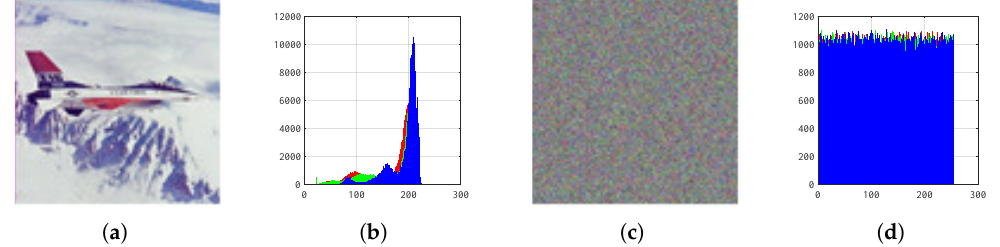
Figure 7. Histograms: ( a ) Airplane image, ( b ) histogram of plain Airplane, ( c ) encrypted Airplane, and ( d ) histogram of encrypted Airplane.